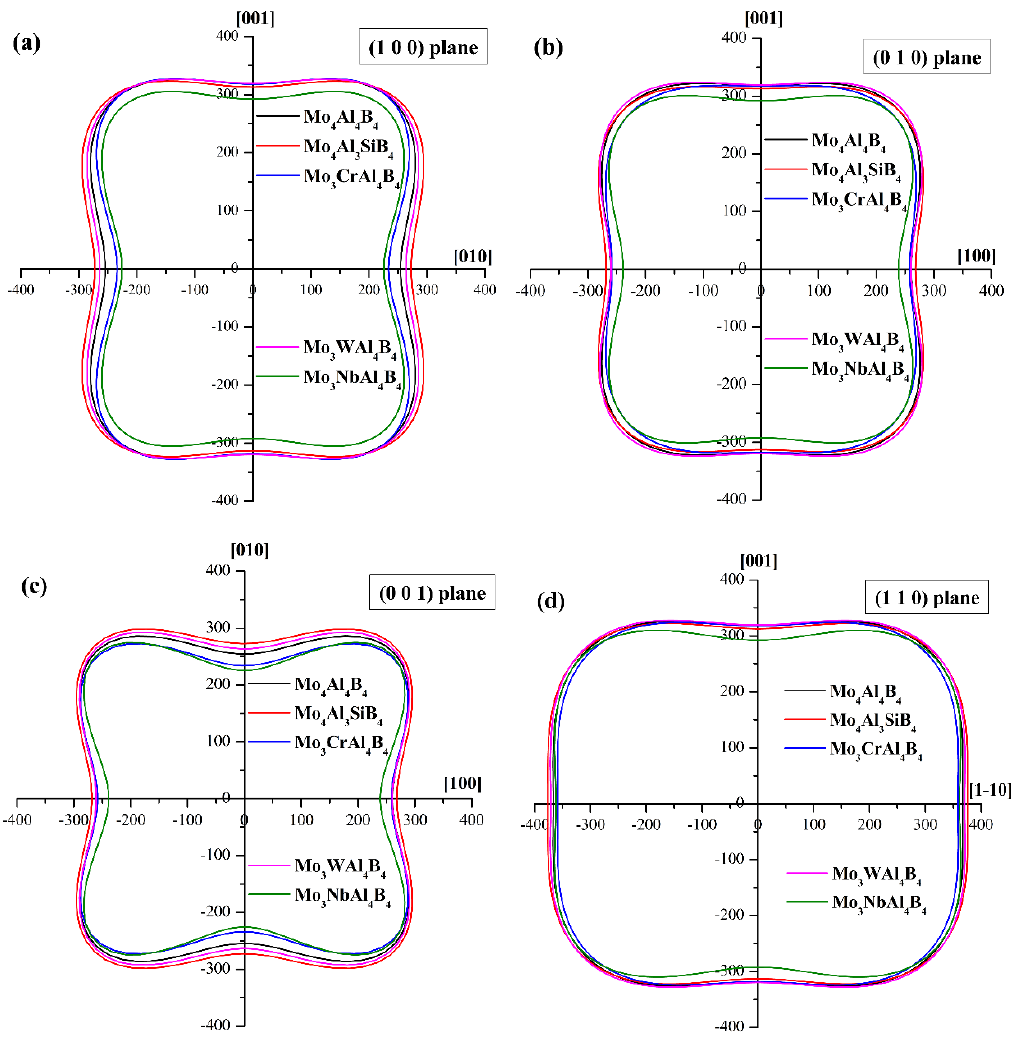
Figure 4. Planar projections of the Young’s modulus (GPa) on different planes: ( a ) on the (1 0 0) plane; ( b ) on the (0 1 0) plane; ( c ) on the (0 0 1) plane; ( d ) on the (1 1 0) plane.